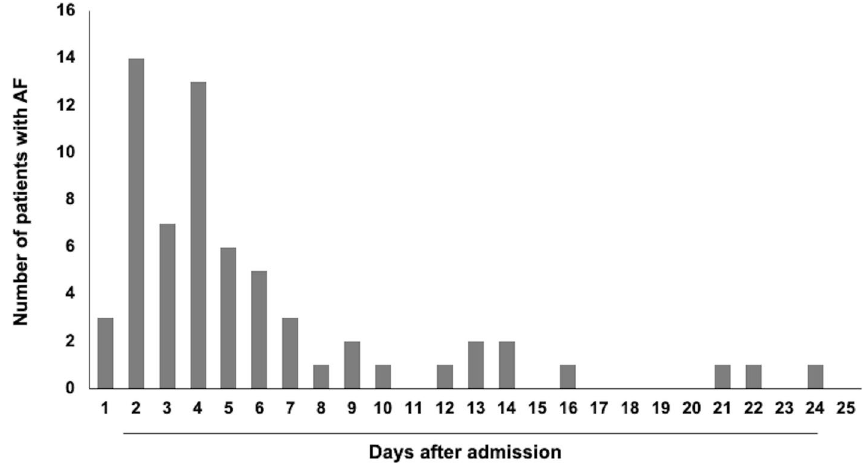
Figure 1. Temporal profile of atrial fibrillation development after admission. Histograms show the number of patients with detection of atrial fibrillation according to the day after